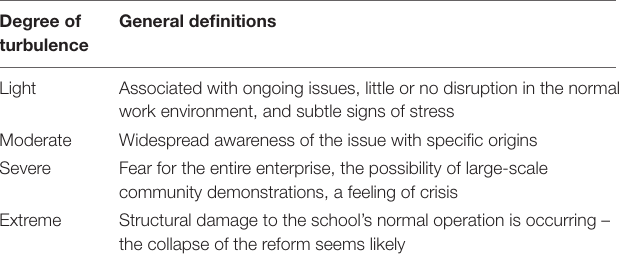
TABLE 1 | Types of turbulence (based on Gross, 1998, 2002, 2020; Gross and Shapiro,